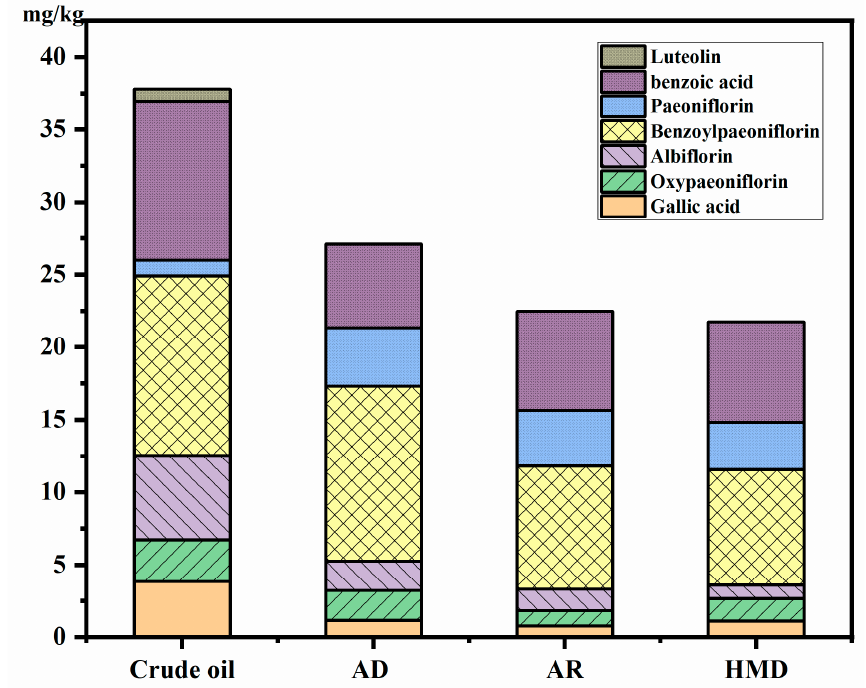
Figure 4. Effects of different deacidification methods on polyphenol components of peony seed